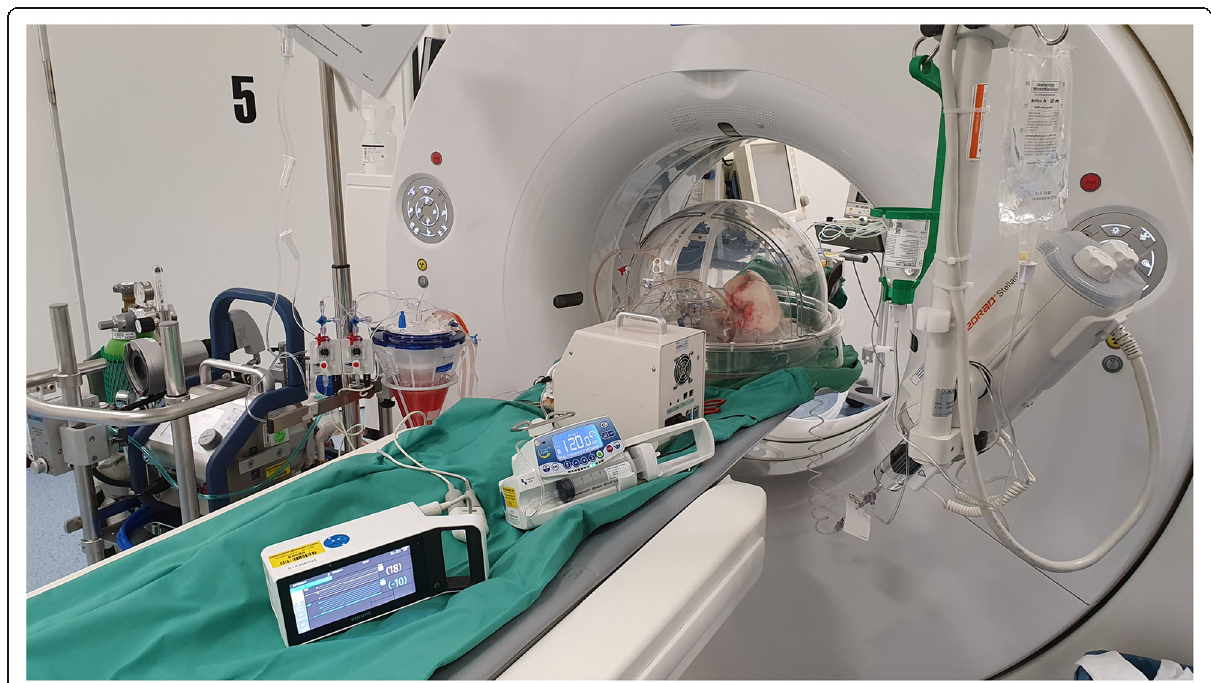
Fig. 2 Actual setup. The lower lung lobe is positioned in the computed tomography gantry